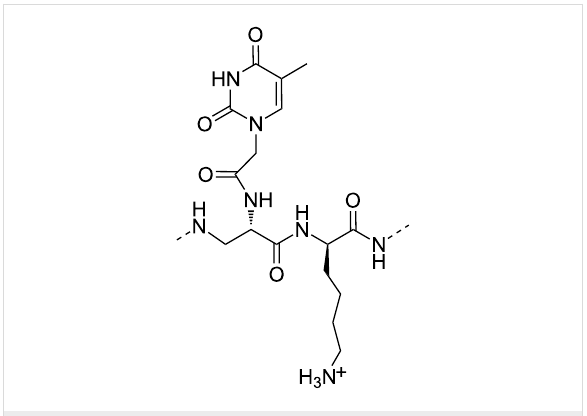
Figure 10: Molecular representation of a nucleopeptide able to bind poly(rA).